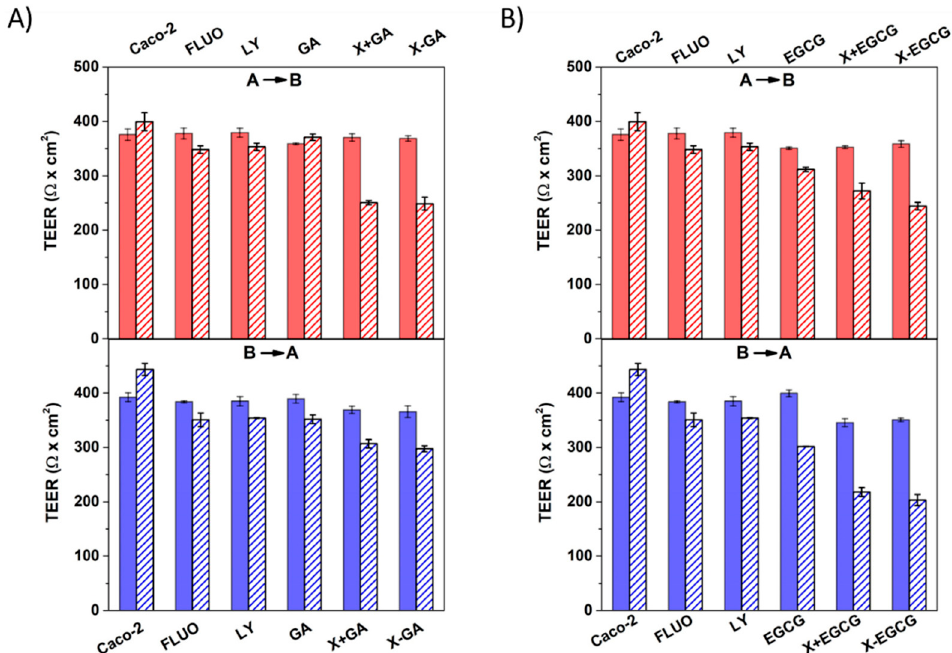
Figure 6. Transepithelial electrical resistance (TEER) measurements of cell monolayers before (full colored bars) and after (patterned bars) apical-to-basolateral (AB) and basolateral-to-apical (BA) studies for a time interval of 8 h. TEER values were recorded for GA, X + GA, and X-GA ( A ) and EGCG, X + EGCG, and X-EGCG ( B ). All data were the mean ± SD of three independent experiments.